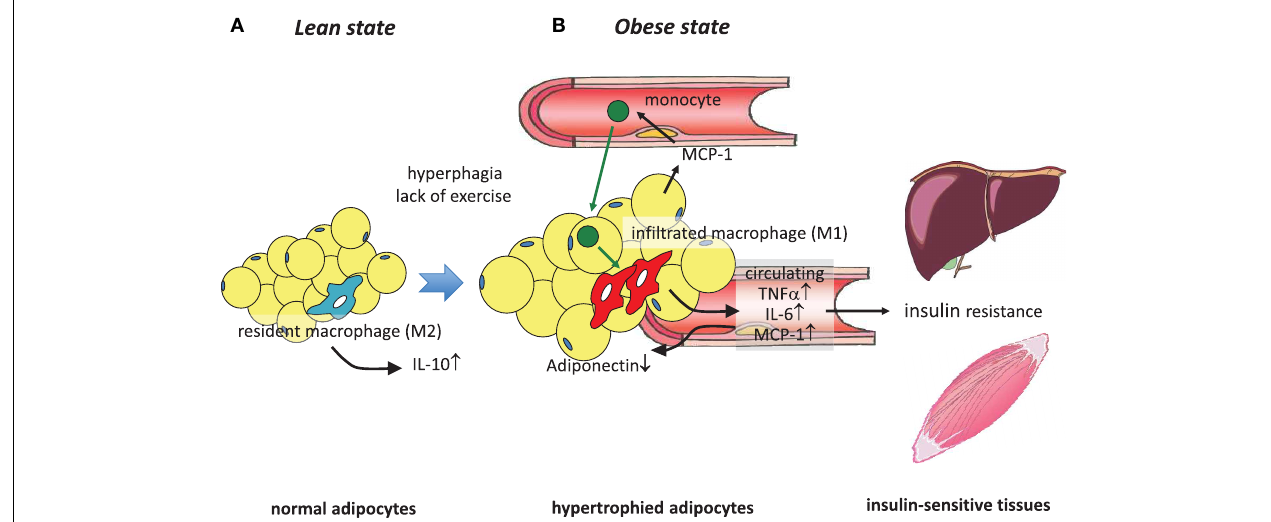
infiltrated monocytes differentiate into activated M1 macrophages, which robustly secrete proinflammatory cytokines such asTNF α , IL-6, and MCP-1, thus contributing to low-grade inflammation in adipose tissue and a decrease of adiponectin. At the same time, these secreted cytokines cause insulin resistance in liver and skeletal muscle by acting as insulin resistance-inducing